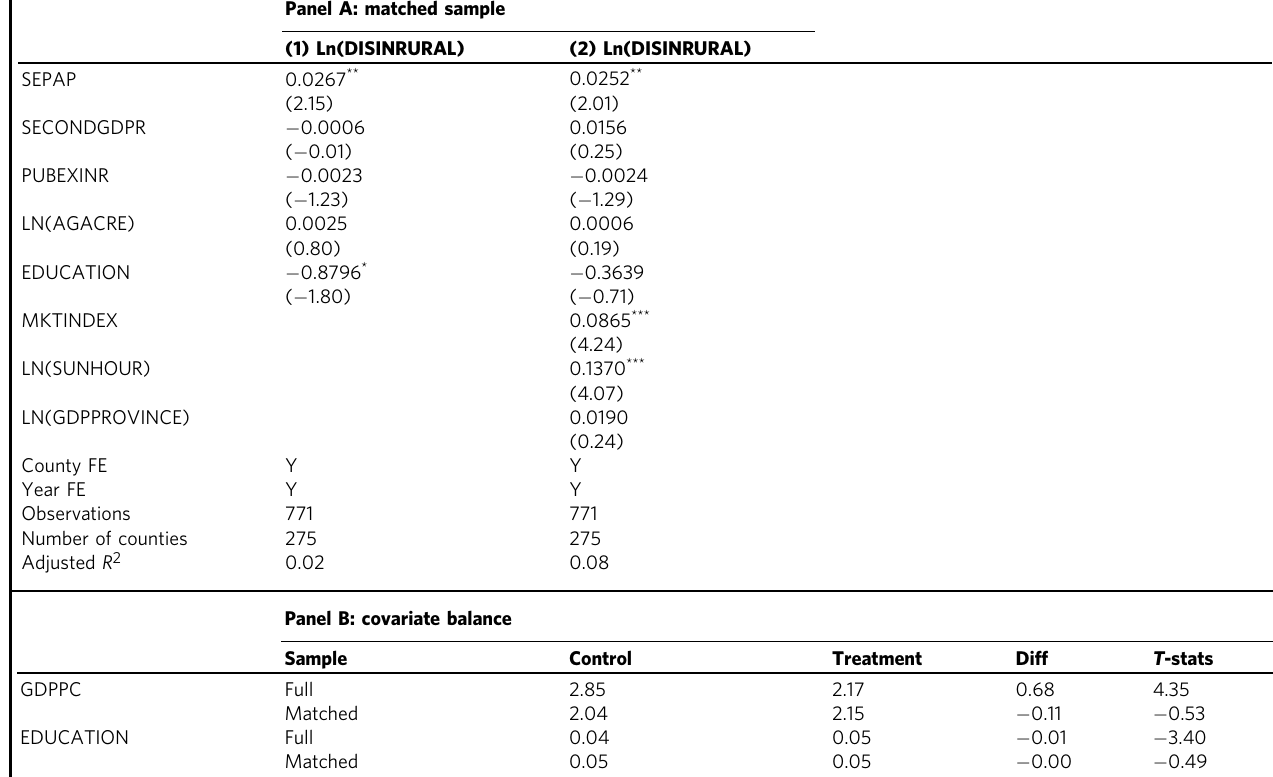
Table 2 Propensity score matching. Panel A: matched